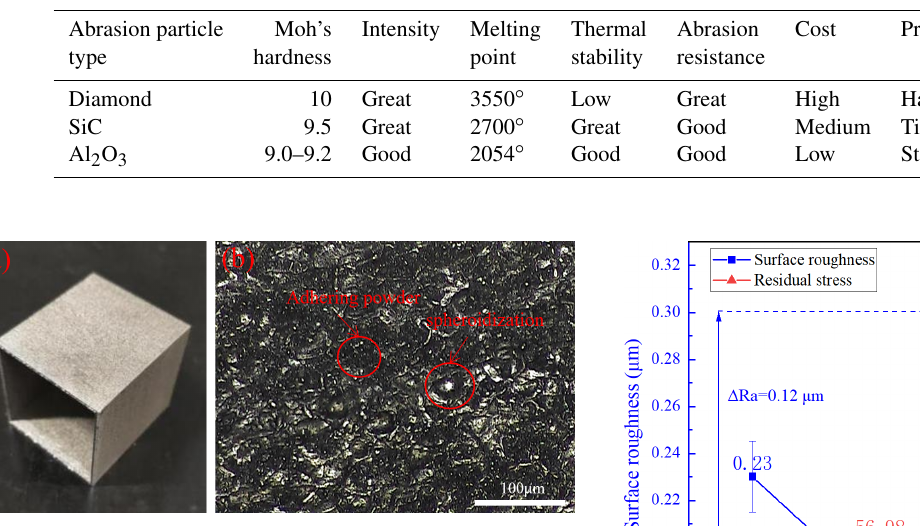
Figure 5. SLM-125HL laser selective melting equipment and 316L powder. Table 4. Performance correlation of abrasive particles.